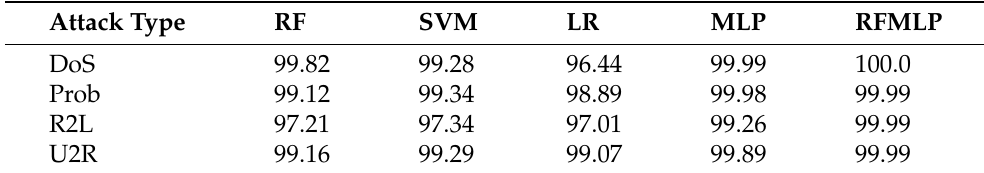
Table 5. Accuracy of classifiers on KDD-CUP 99 dataset.